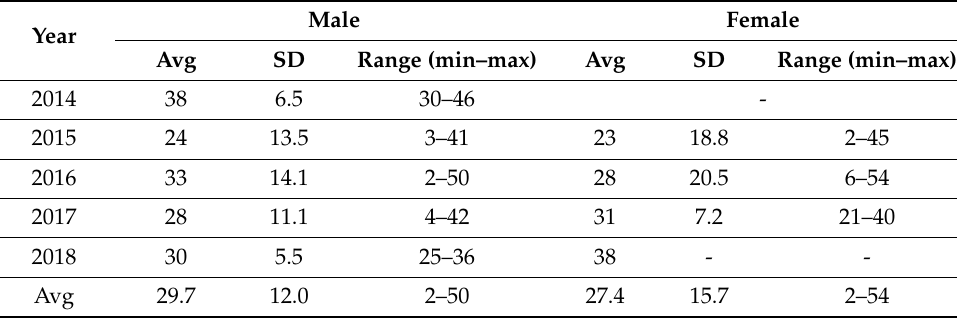
Figure 2. CO poisoning fatal cases (n = 59) by gender (2014–2018). Table 3. CO poisoning confirmed cases (n = 59) by age